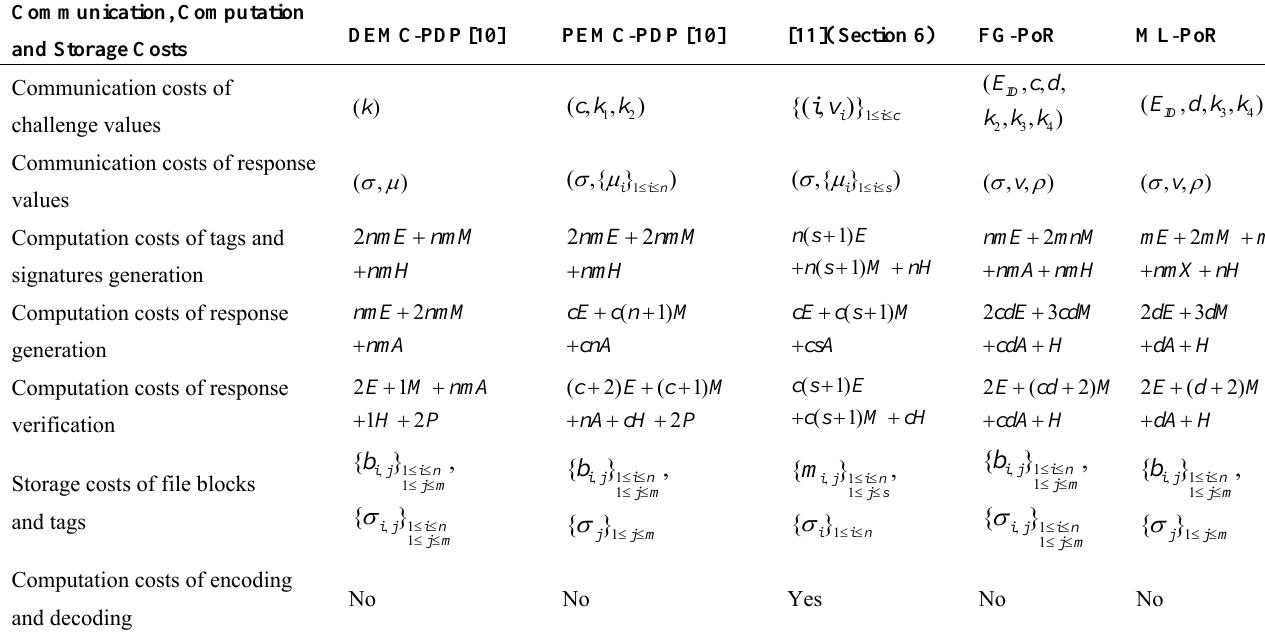
Table 1. Comparison of communication, computation and storage costs for the five